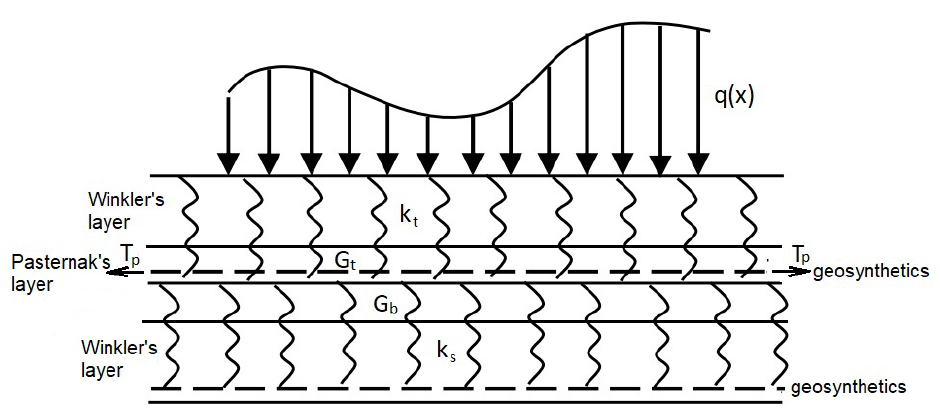
Figure 3: The example of a loading (substituted load) of a railway bedding